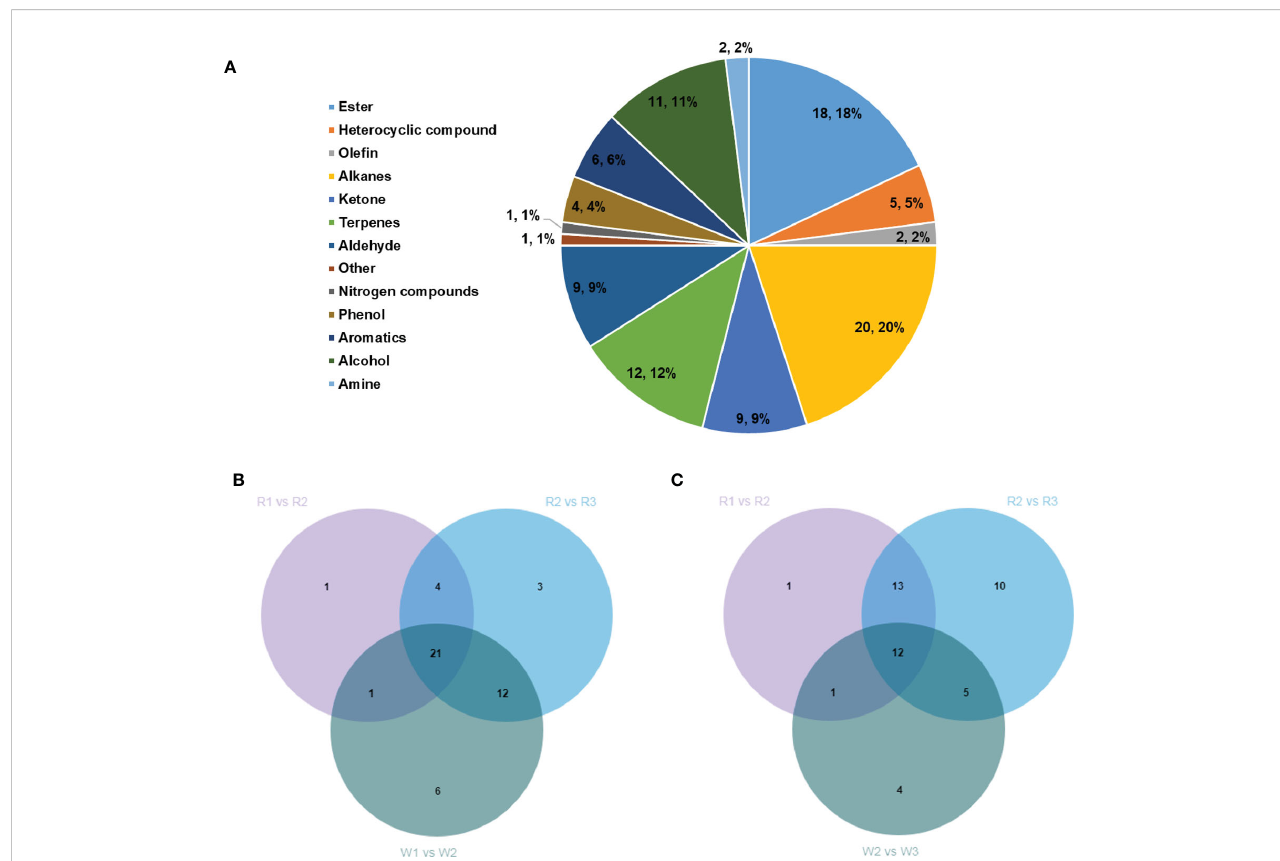
FIGURE 6 (A) Classi fi cation and proportion of a total of 100 volatile organic compounds (VOCs) detected in Macadamia integrifolia fl owers at different development stages. (B) Venn diagram analysis of the upregulated VOCs in the W1 vs. W2 group compared with the R1 vs. R2 and R2 vs. R3 nut fl ower comparison groups. (C) Venn diagram analysis of the upregulated VOCs in the W2 vs. W3 group compared with the R1 vs. R2 and R2 vs. R3 nut fl ower comparison groups. The percentages in the pie chart represent the total proportions of the different classi fi ed VOCs in nut fl owers. The numbers in the Venn diagram represent the shared or unique VOC counts in the different comparison groups. R and W denote red and white nut fl owers, respectively.